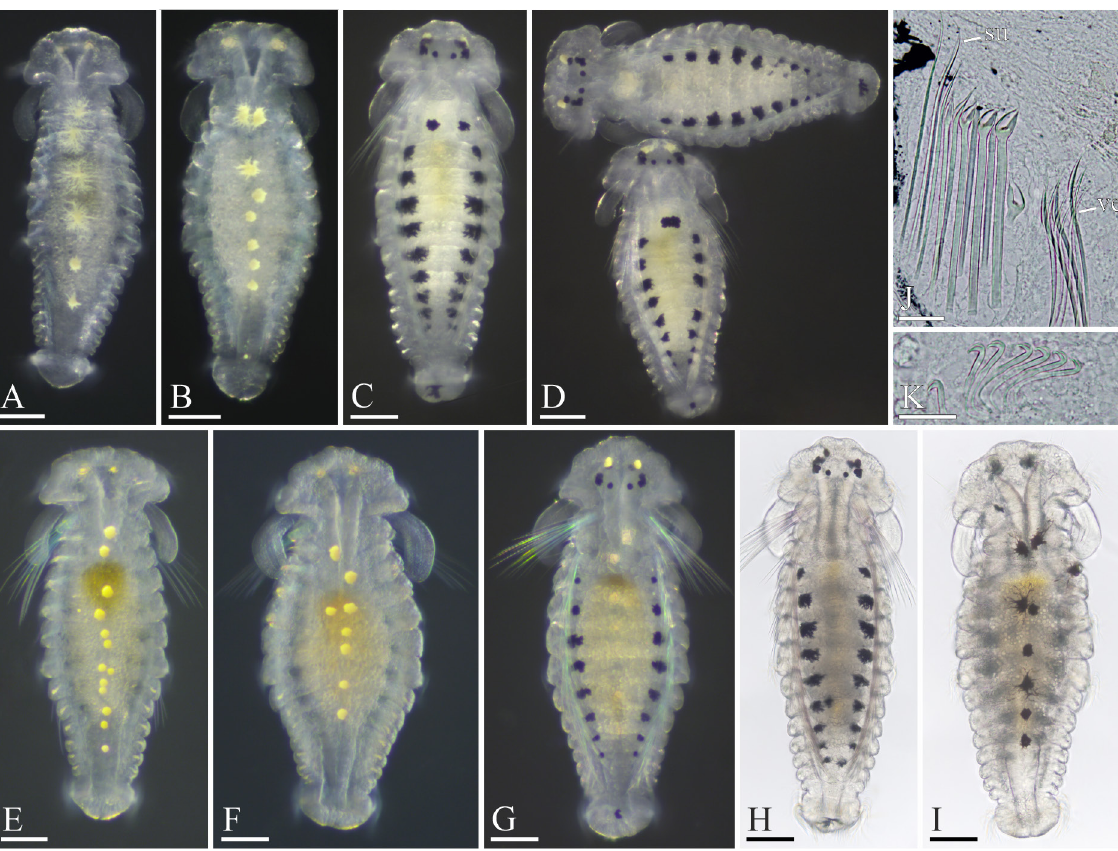
Fig. 9. Larval morphology of Pseudopolydora antennata (Claparède, 1868). Live larvae in reflected (A–G) and transmitted (H–K) light. A . 13-chaetiger larva, ventral view. B . 14-chaetiger larva,